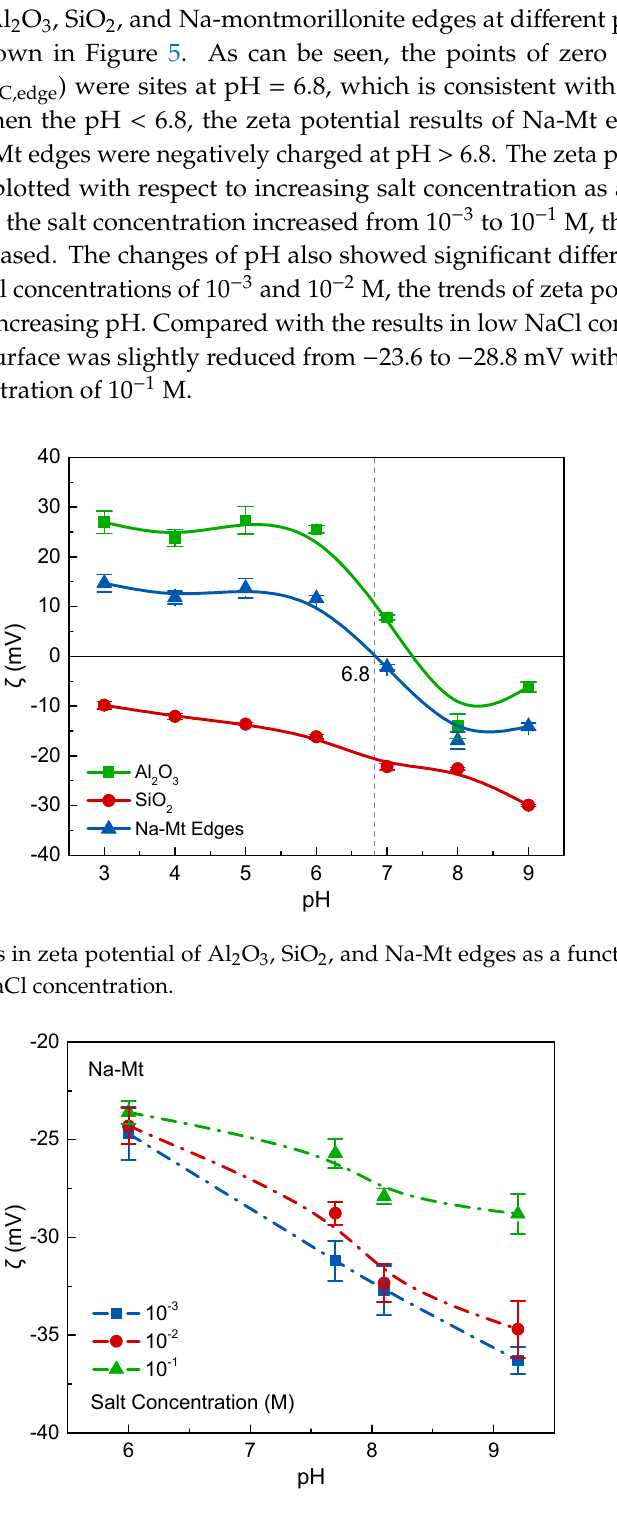
Figure 6. The changes in zeta potential of Na-Mt surface with respect to increasing salt concentration as a function of pH.